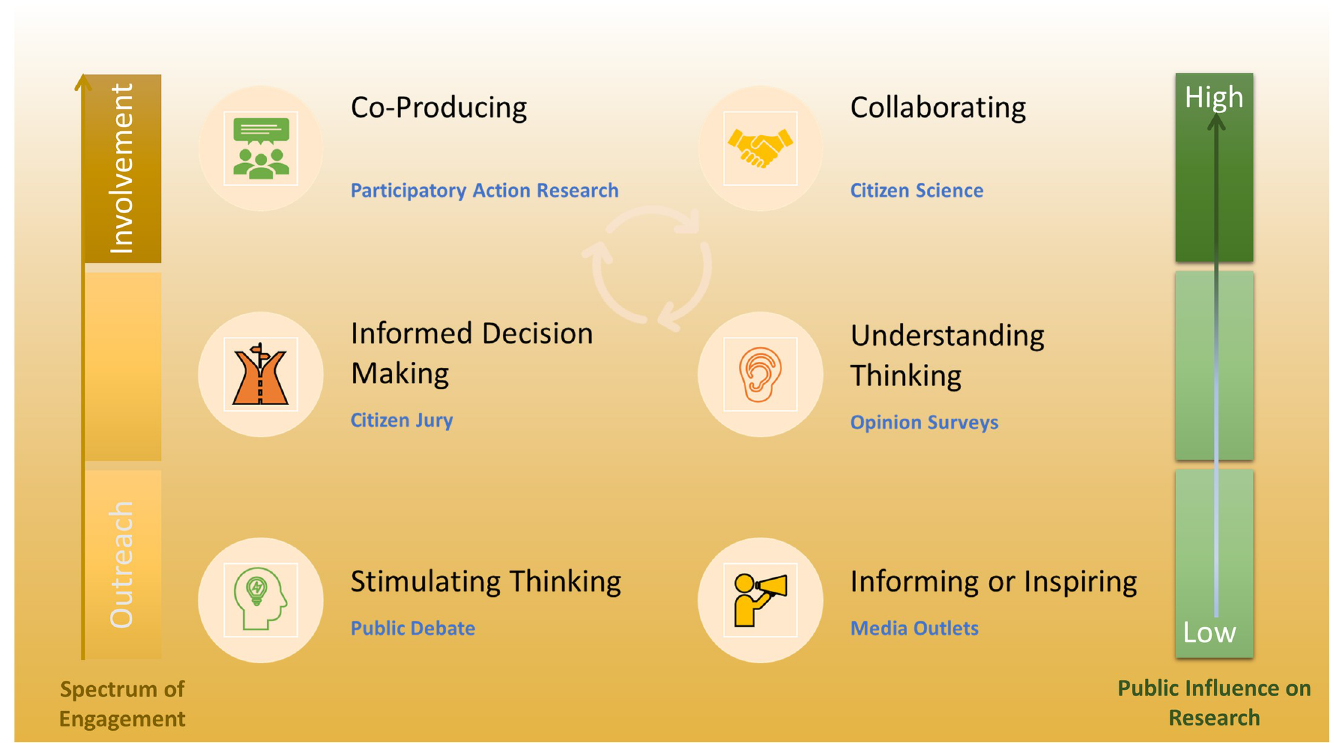
Fig 1. Public involvement within the spectrum of public engagement. Public Engagement is a broad term that includes the multi-faceted and varied ways researchers engage with others outside their field of expertise. Public engagement in research consists of different levels of activities, characterised based on their ability to influence research. These frequently overlap, as successful higher-level engagement is usually built on strong foundational (lower level) engagement.